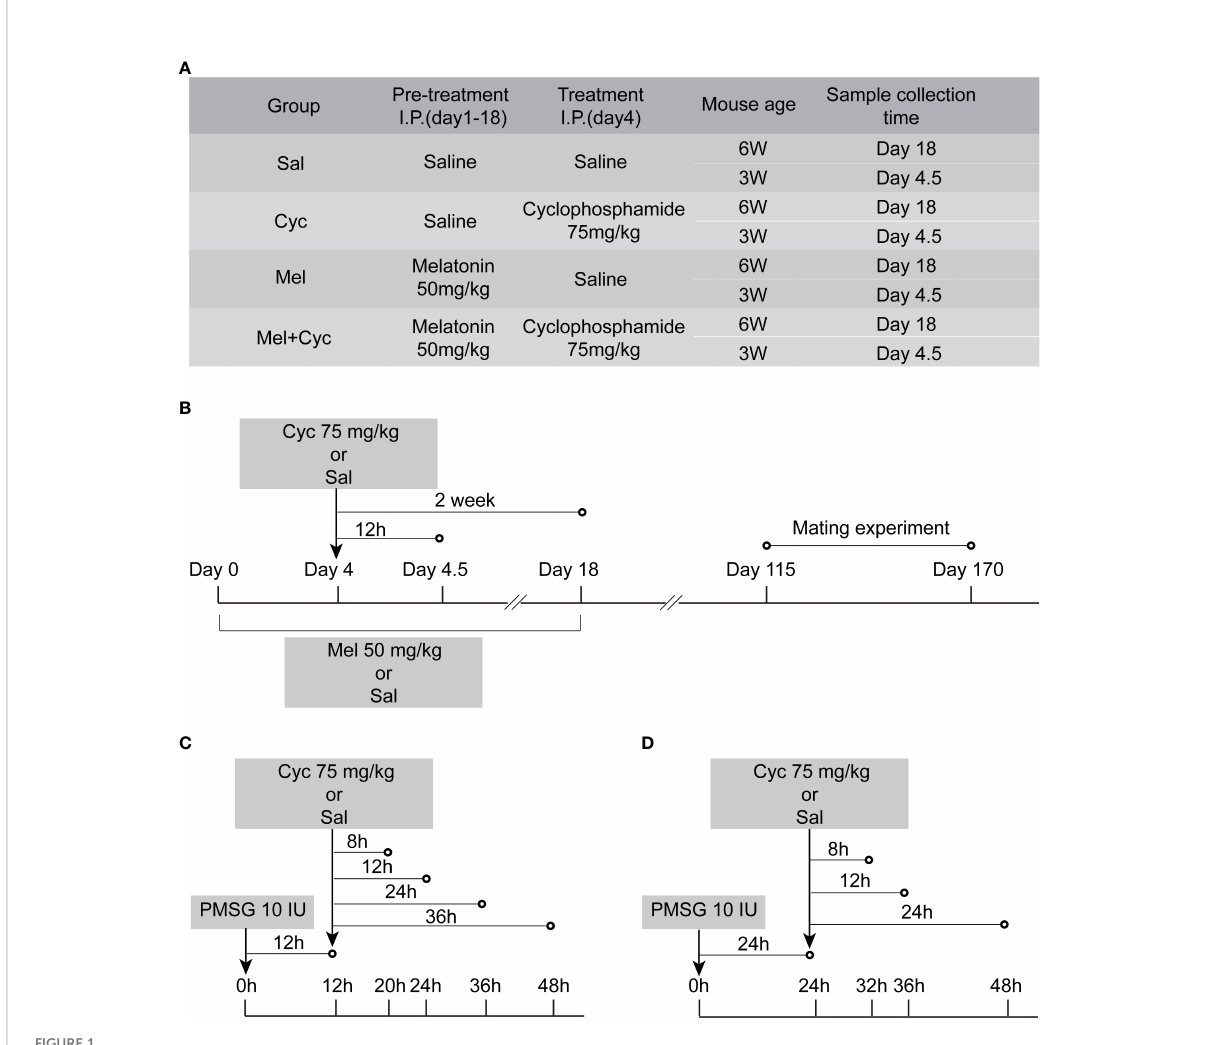
FIGURE 1 Graphic illustration of experimental schedule. (A) Mice were randomly divided into four groups. (B) Six or three-week-old ICR mice were pre- treated with i.p. injections of Mel or Sal once daily (at 24 h intervals) for four consecutive days before achieving Cyc injection, and for 14 additional days during chemotherapy treatment. On Day 4, mice were injected with Sal or Cyc (75 mg/kg). Blood and/or ovaries were collected 12 h or two weeks after Cyc injection. Fertility assessment was performed 115 days after Cyc injection. (C) Three-week-old prepubertal female mice were injected i.p. with 75 mg/kg body weight Cyc 12 h after injection of PMSG. Mice were sacri fi ced 8, 12, 24, or 36 h after chemotherapy treatment and their ovaries were excised (n = 4). (D) Prepubertal female mice were injected i.p. with 75 mg/kg body weight Cyc 24 h after injection of PMSG. Mice were sacri fi ced 12, 24, or 36 h after chemotherapy treatment and their ovaries were